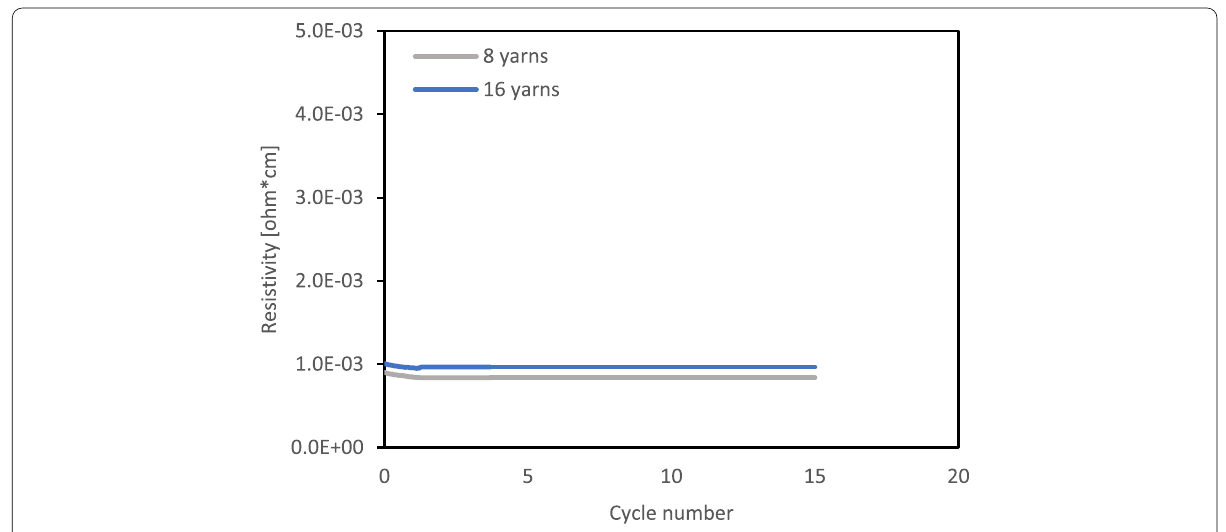
Fig. 16 Electrical resistivity of the braided composite at strain of 22% at a rate of 50 mm/min during 15 cycles